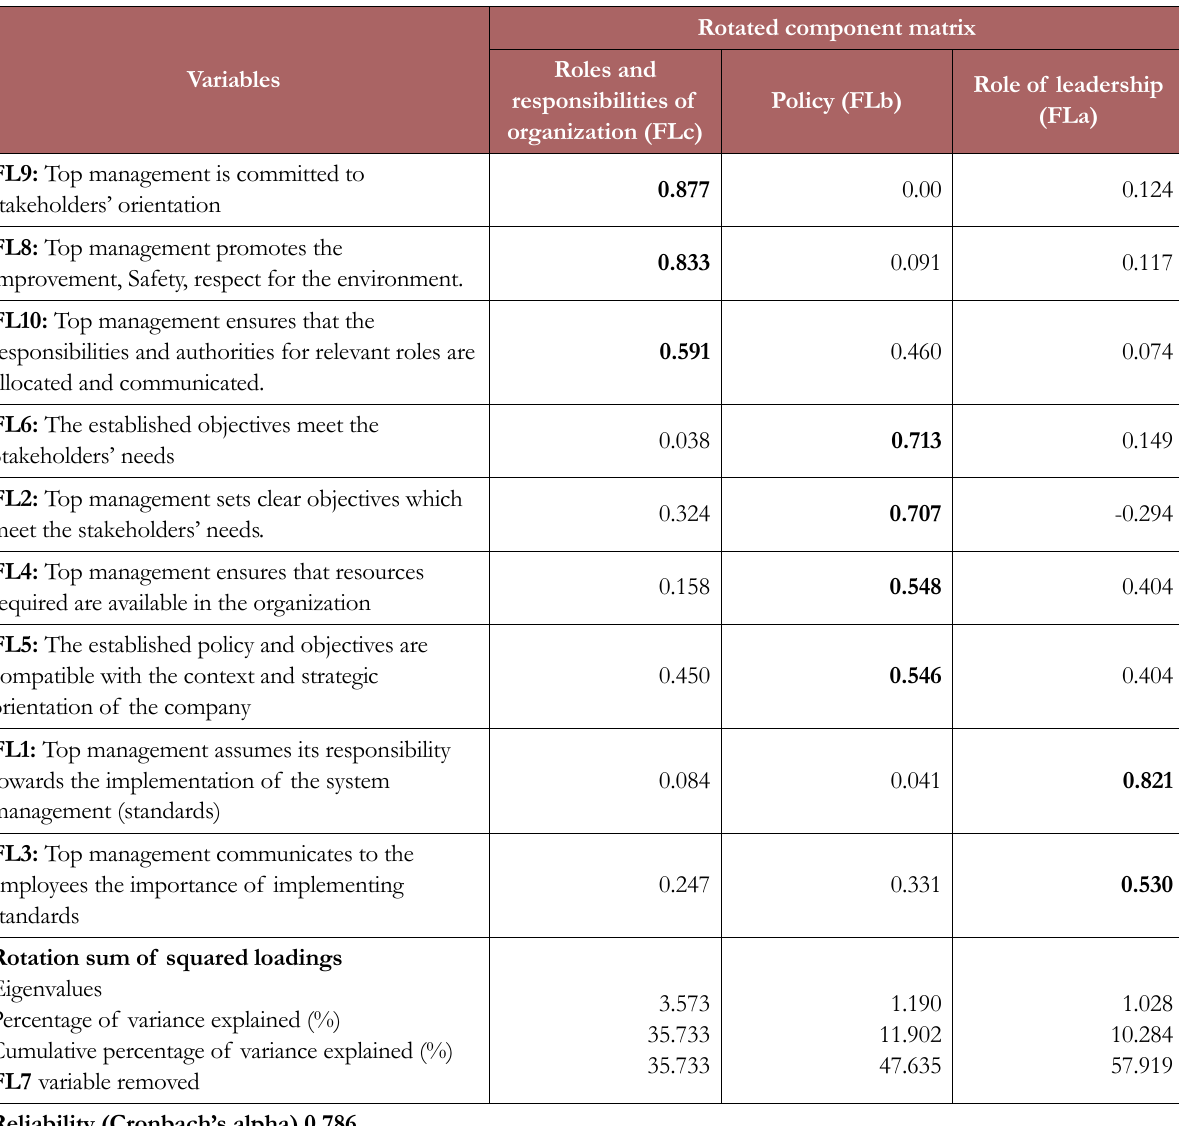
Table 6. EFA of the FL